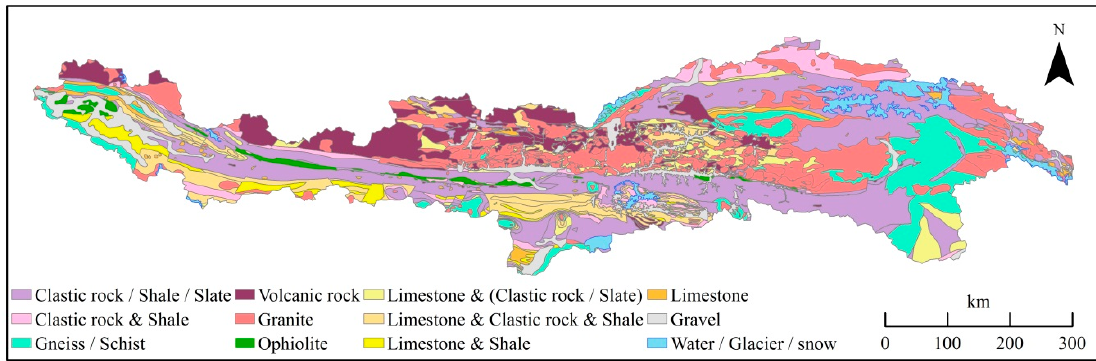
Figure 2. Geologic map of the Yarlung Tsangpo River Basin from the Geological Atlas of China (2001).